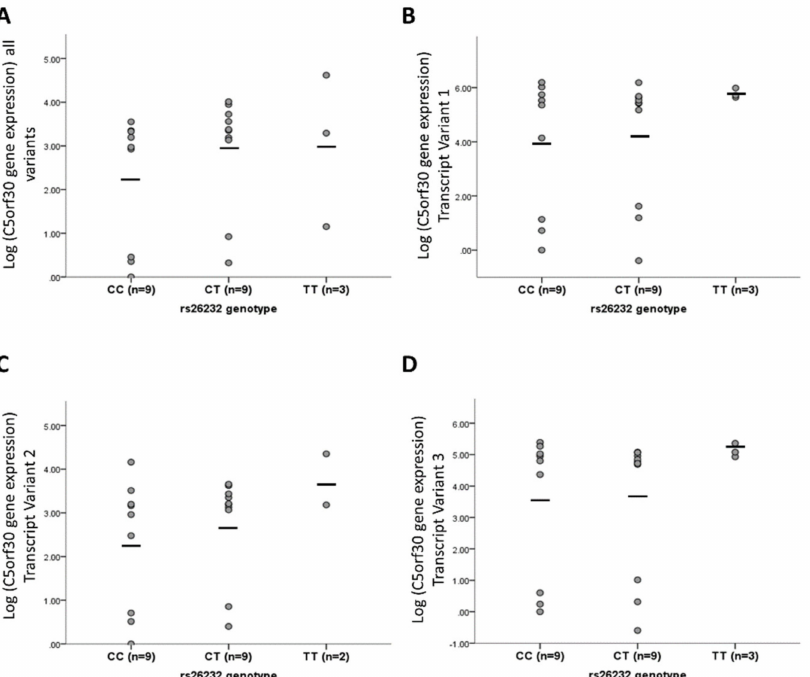
Figure 3. rs26232 is not an eQTL for C5orf30. rs26232 genotype was not associated with ( A ) total C5orf30 mRNA (all variants) ( p = 0.506), ( B ) variant 1 ( p = 0.469), ( C ) variant 2 ( p = 0.352), or ( D ) variant 3 ( p = 0.482). Gene expression is analysed using relative quantitation (RQ) to the endogenous control HPRT1. Y -axis is mean Log 2 transformed RQ values per patient RASF line. Each circle represents the average of an individual donor. Horizontal black bars represent the cohort